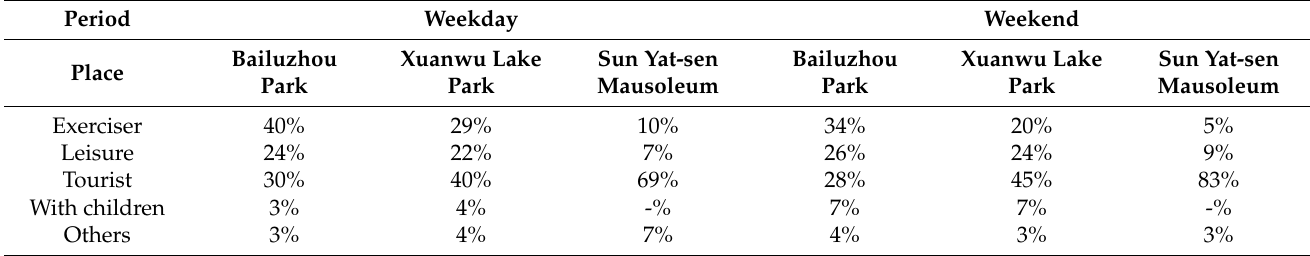
Table 3. Typical composition of park visitor types, which was used to determine the types of behaviors for visitors.